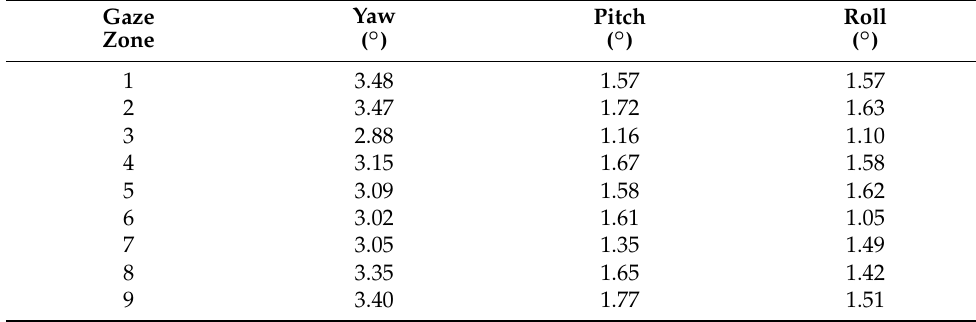
Table 2. Mean absolute error of head pose estimation in each gaze zone. Gaze Zone